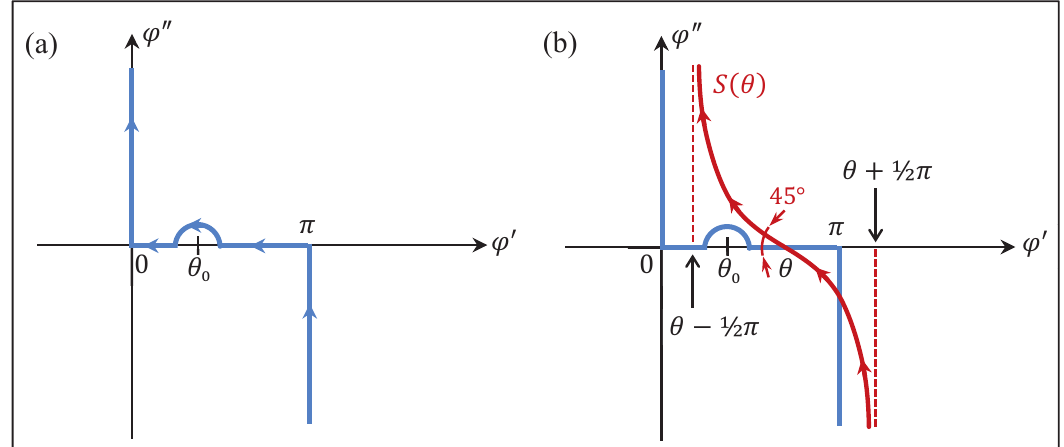
Fig.7 . (a) Contour of integration in the complex (cid:2030) -plane corresponding to the integration path in the (cid:2026) -plane (cid:3051) shown in Fig.6(b). By definition, (cid:2026) = cos (cid:2030) , which results in (cid:1863) = (cid:1863) = (cid:1863) sin (cid:2030) , a well-defined function (cid:2026) (cid:3053) (cid:3053) (cid:3299) (cid:3116) (cid:3116) everywhere in the (cid:2030) -plane that does not need branch-cuts. The small bump in the integration path around corresponds to the small semi-circular part of the contour in Fig.6(b). The negative values of (cid:2026) (cid:3051)(cid:4595) on (cid:2030) = (cid:2016) (cid:3116) the semi-circle translate, in accordance with Eq.(69), into positive value of (cid:2030) (cid:4595) on the corresponding bump. (b) Along the steepest-descent contour (cid:1845) ( (cid:2016) ) that passes through the saddle-point (cid:2030) = (cid:2016) , Re[cos( (cid:2030) (cid:3398) (cid:2016) )] is constant. At the saddle-point, (cid:1845) ( (cid:2016) ) makes a 45° angle with the horizontal and vertical lines, which represent contours along which Im[cos( (cid:2030) (cid:3398) (cid:2016) )] is constant. (cid:1845) ( (cid:2016) ) also has the property that Im[cos( (cid:2030) (cid:3398) (cid:2016) )] , which is zero at the saddle-point, rises toward (cid:955) (continuously and symmetrically on both sides of the saddle) as (cid:2030) moves away from the saddle-point along the